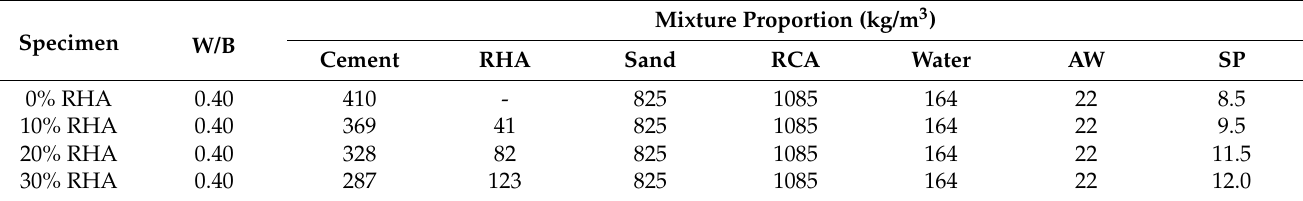
Table 3. The mixture proportion of the RHA recycled concrete